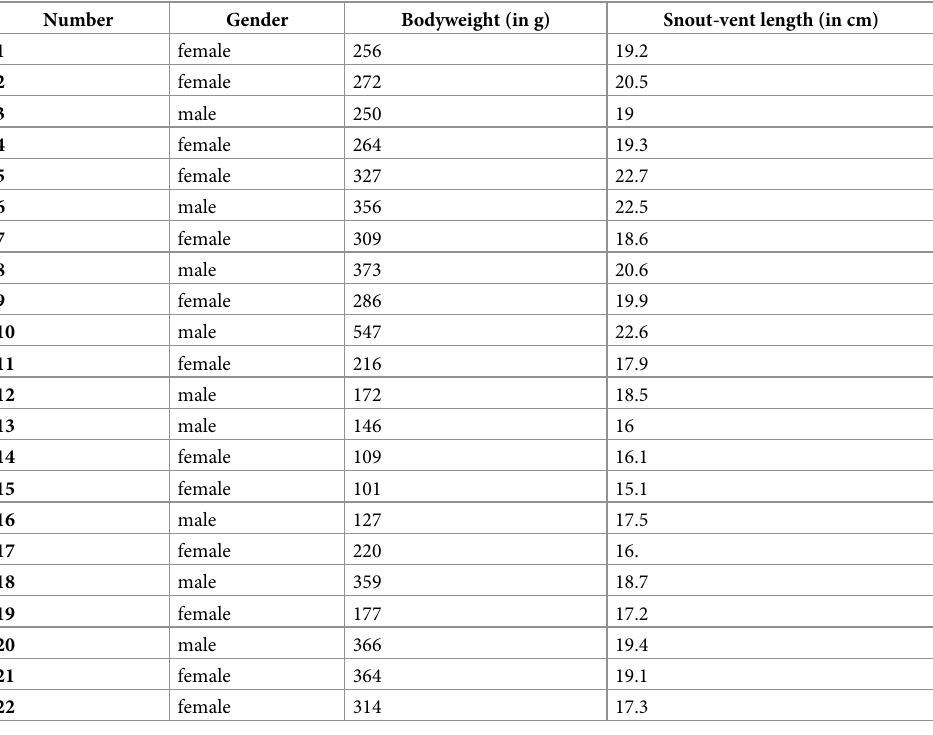
Table 2. Live adult bearded dragon used in the contrast media studies.